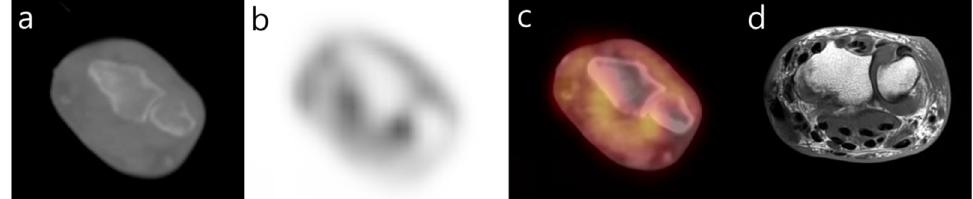
Figure 3. Axial 18 F-FDG PET-CT image ( a – c ) of the left wrist demonstrates periarticular uptake and associated osseous erosions. Axial T1-weighted MR image ( d ) reconfirms erosion and periarticular hypointense amyloid deposits.